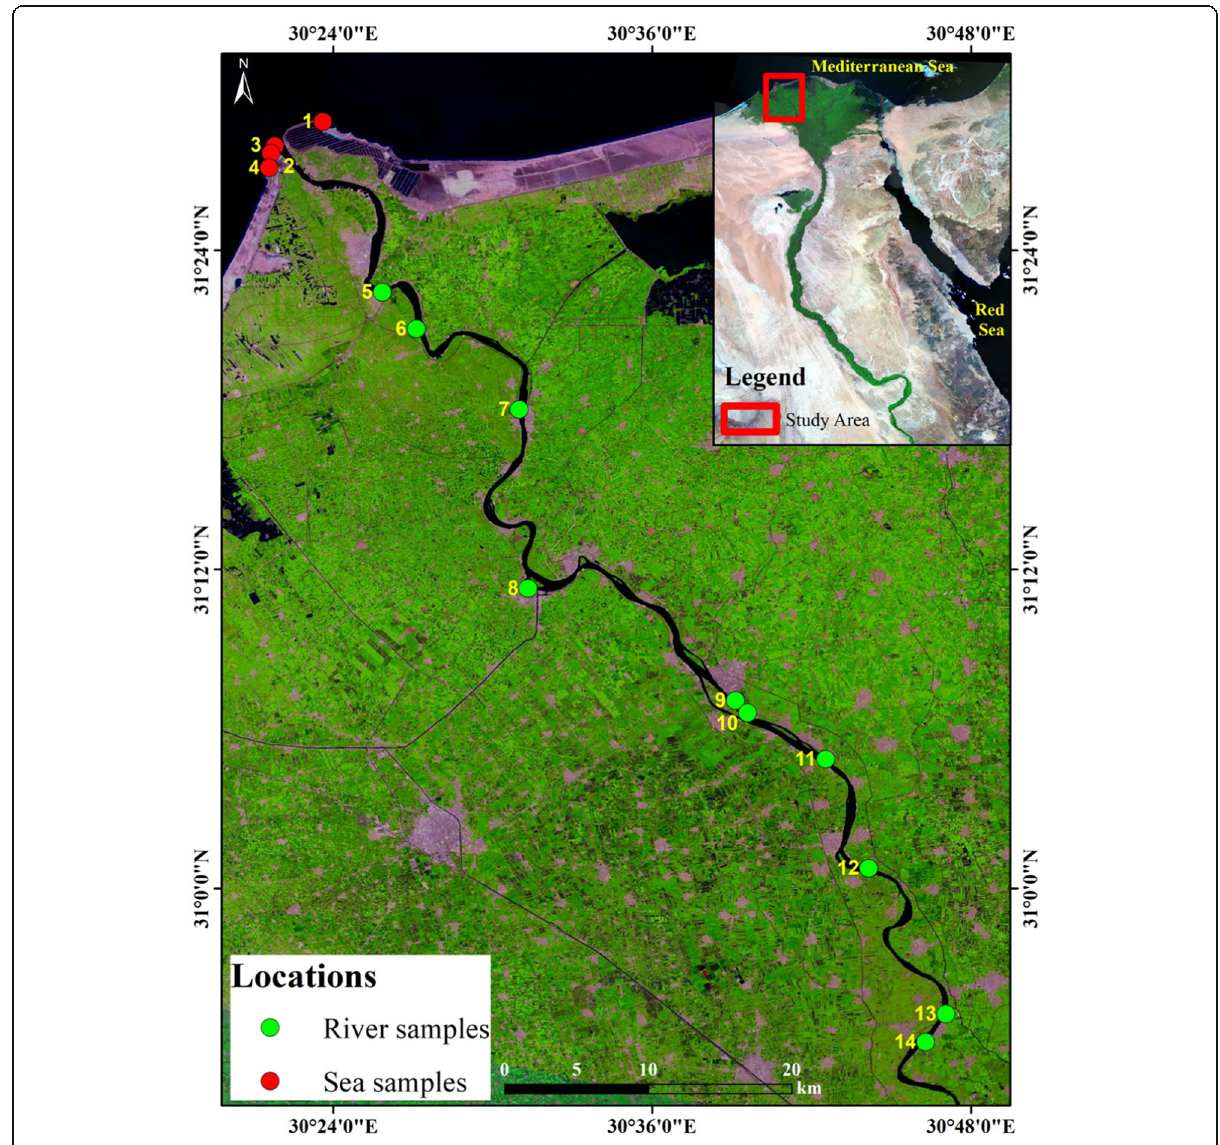
Fig. 1 Sampling locations from the River Nile and the